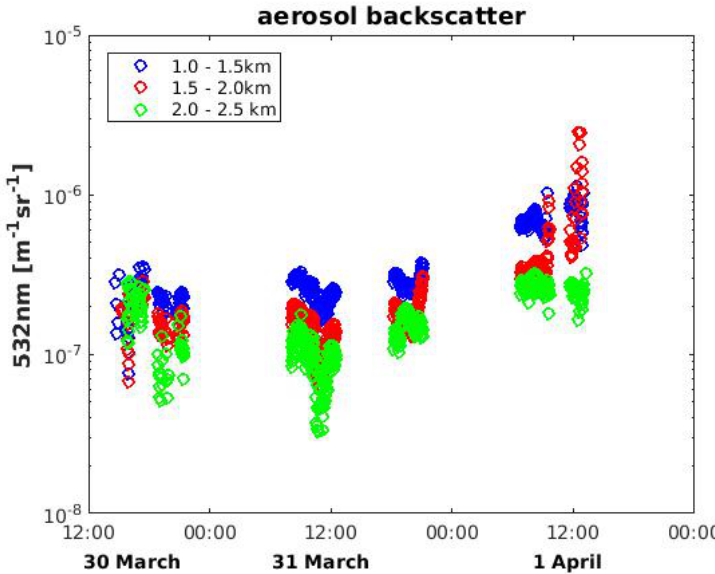
Figure 22. Averaged aerosol backscatter in three different altitude